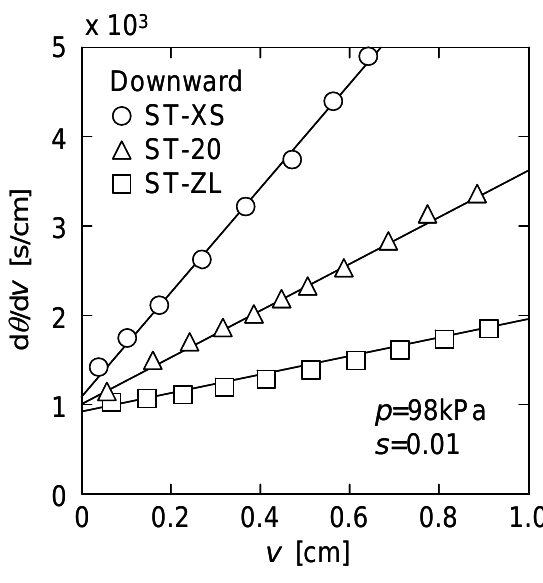
Figure 3. Reciprocal filtration rate in downward UF.